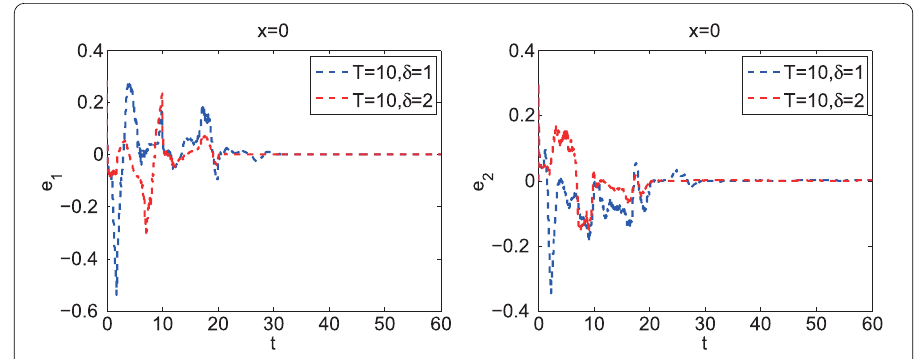
Figure 3 Asymptotic behaviors of the synchronization errors with differential control width.